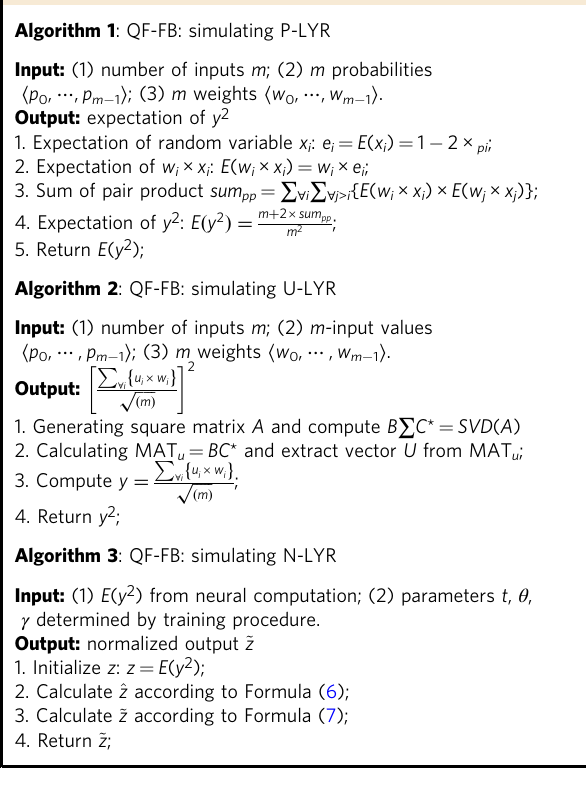
Box 1 | Three algorithms in QF-FB Algorithm 1 : QF-FB: simulating P-LYR